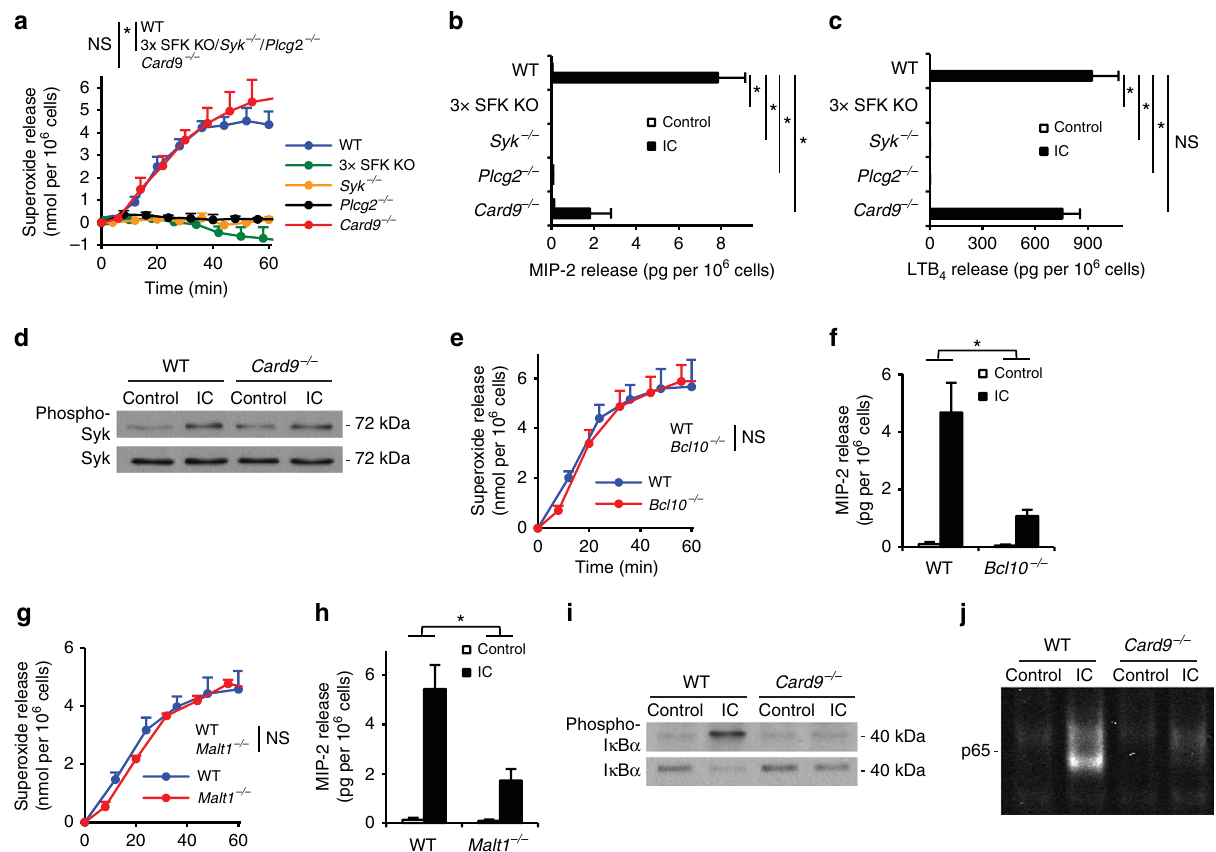
Figure 7 | Upstream and downstream components of the CARD9 signalling pathway. ( a – c ) Wild type (WT), Hck (cid:2) / (cid:2) Fgr (cid:2) / (cid:2) Lyn (cid:2) / (cid:2) (3 (cid:3) SFK KO), Syk (cid:2) / (cid:2) , Plcg2 (cid:2) / (cid:2) or Card9 (cid:2) / (cid:2) neutrophils were placed on immobilized immune complex (IC) surfaces. Their superoxide release ( a ), MIP-2 levels ( b ) and LTB 4 ( c ) release were determined. ( d ) WTand Card9 (cid:2) / (cid:2) neutrophils were plated on IC surfaces for 10min, the phosphorylation and the total amount of Syk in cell lysates was determined by western blot after immunoprecipitation. ( e – h ) Bcl10 (cid:2) / (cid:2) and Malt1 (cid:2) / (cid:2) neutrophils showed similar functional phenotypes on IC surfaces like Card9 (cid:2) / (cid:2) neutrophils: they had intact superoxide release ( e , g ) and defective chemokine production ( f , h ). ( i ) WT and Card9 (cid:2) / (cid:2) neutrophils were stimulated for 20min; the phosphorylation and degradation of I k B a was followed by western blotting from whole cell lysates. ( j) IC-activated WTand Card9 (cid:2) / (cid:2) neutrophils were lysed after 20min; the activation and nuclear translocation of NF- k B was determined by infrared dye- labelled NF k B consensus binding site probes. Kinetic curves in a , e and g show mean and s.e.m. of three to four independent experiments. Control data points were subtracted. Graphs in b , c , f and h represent data from two to four independent experiments. ( d , i,j ) Representative of two to three independent experiments. * P o 0.05; NS, statistically not significant (two-way ANOVA); see the text for actual P